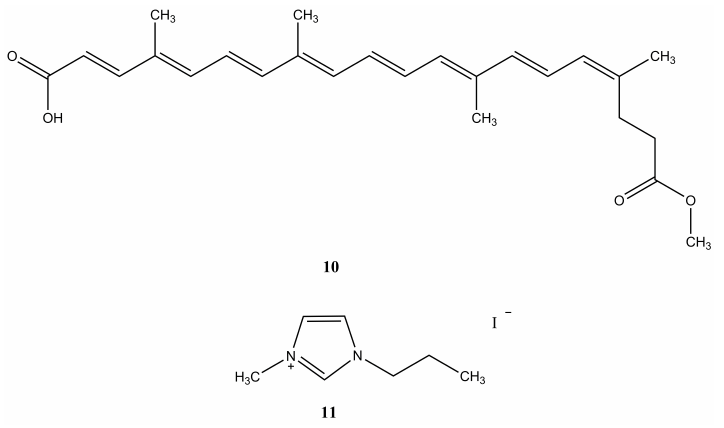
Figure 3. Structure of cis